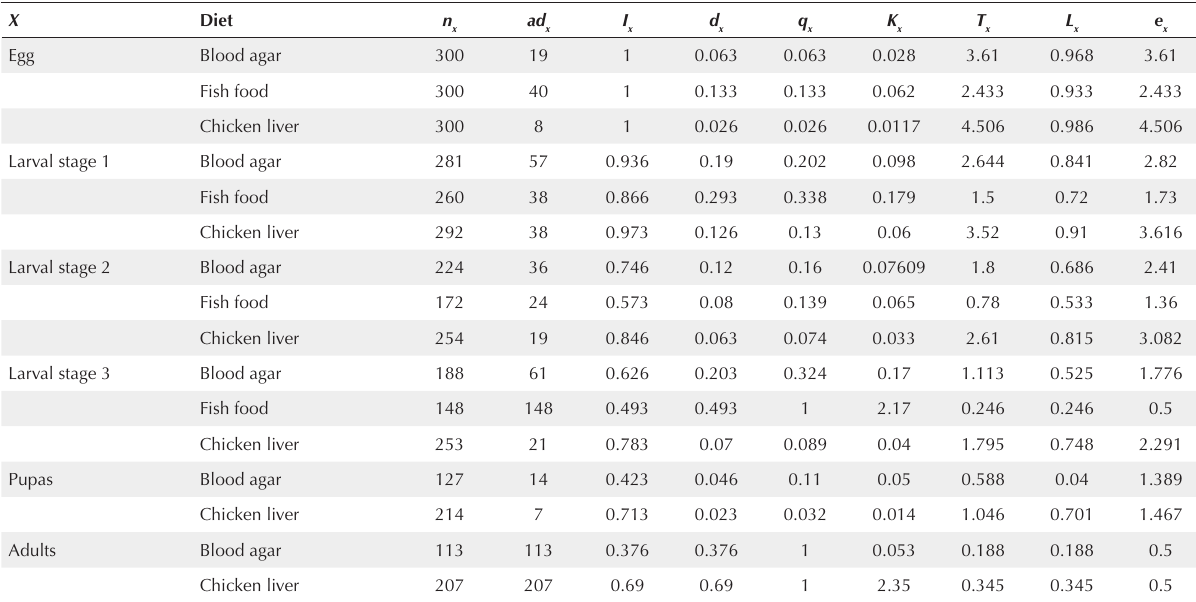
Table 4. The Life Table of L. sericata X Diet Egg Blood